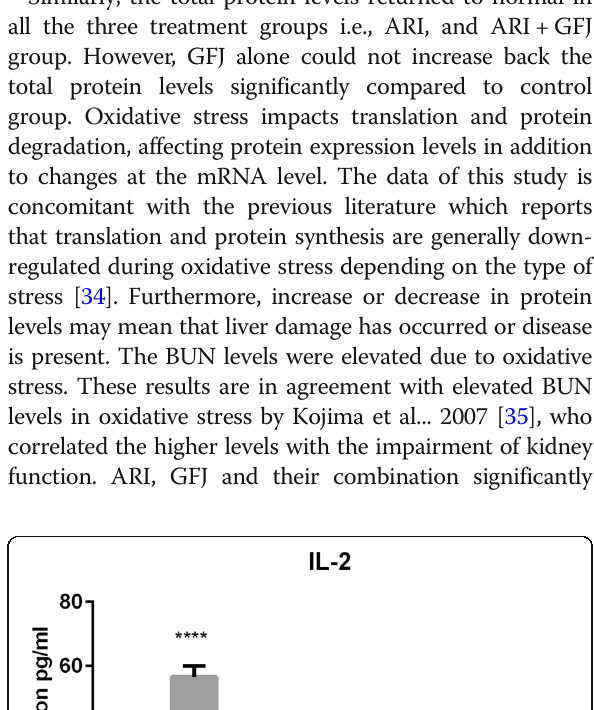
* Statistically significant when compared to control group ( P <0.0001) P <0.0001) # Statistically significant when compared to H 2 O 2 treated group ( Data presented as (mean±SE) of three independent experiments and No. of animals (n=10)